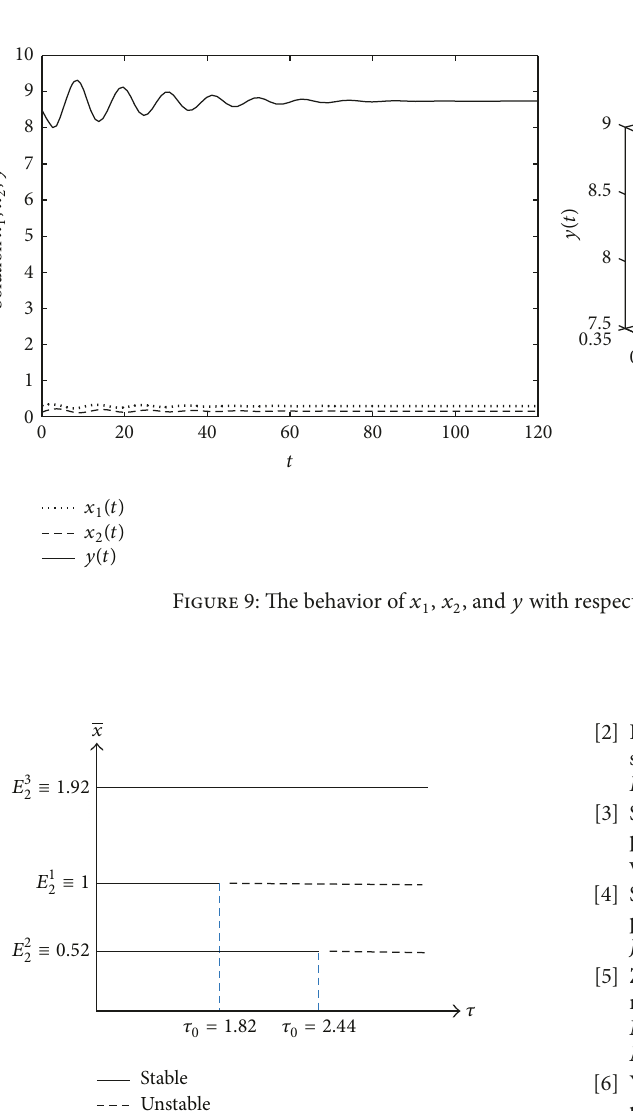
Figure 10: Bifurcation diagram for Example